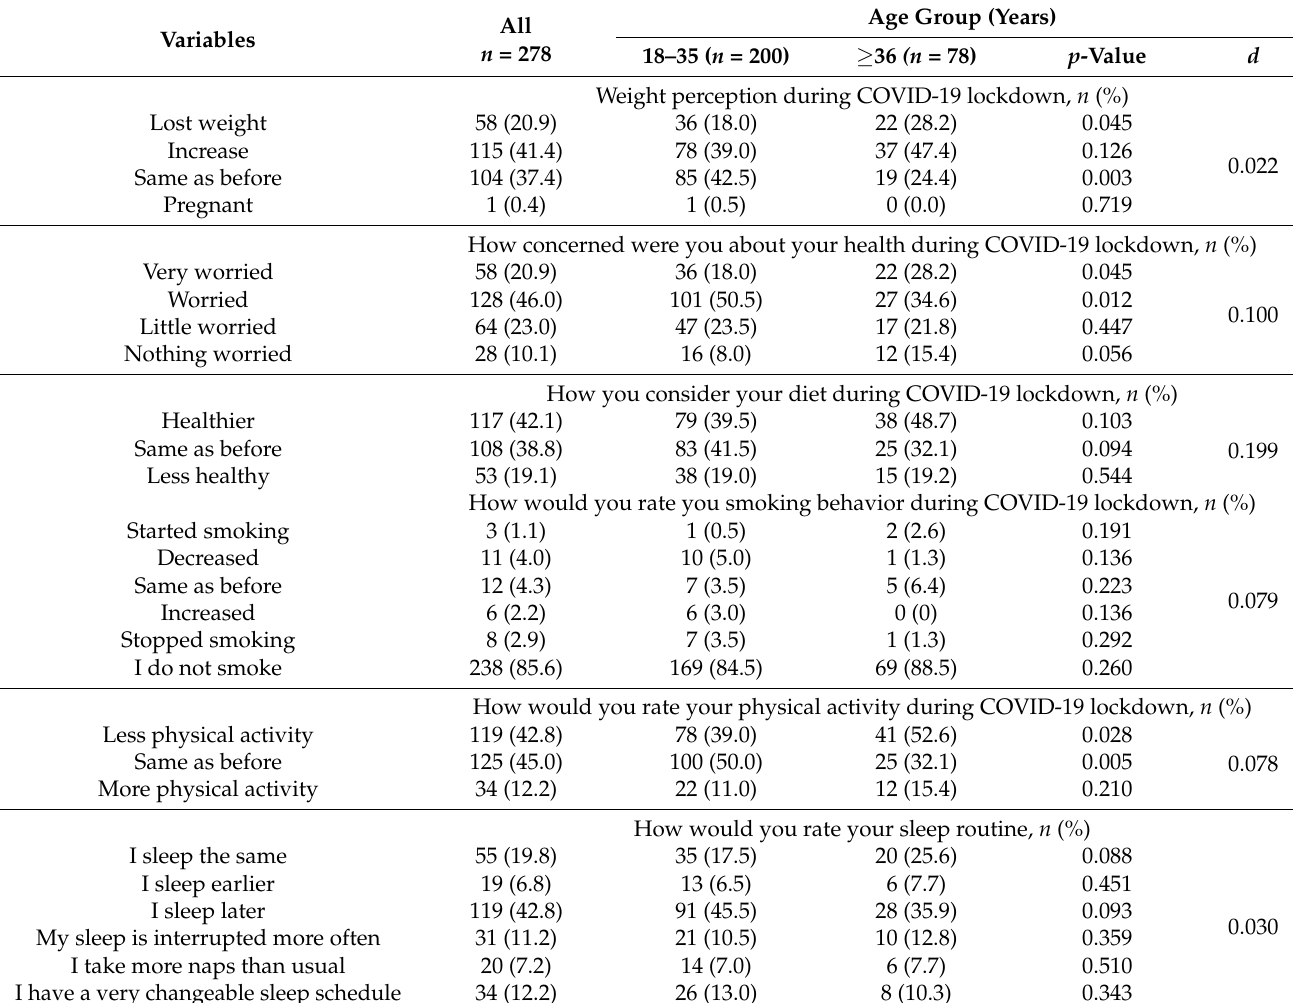
Table 4. Additional questions on health and lifestyle changes during COVID-19 lockdown by age ( n =